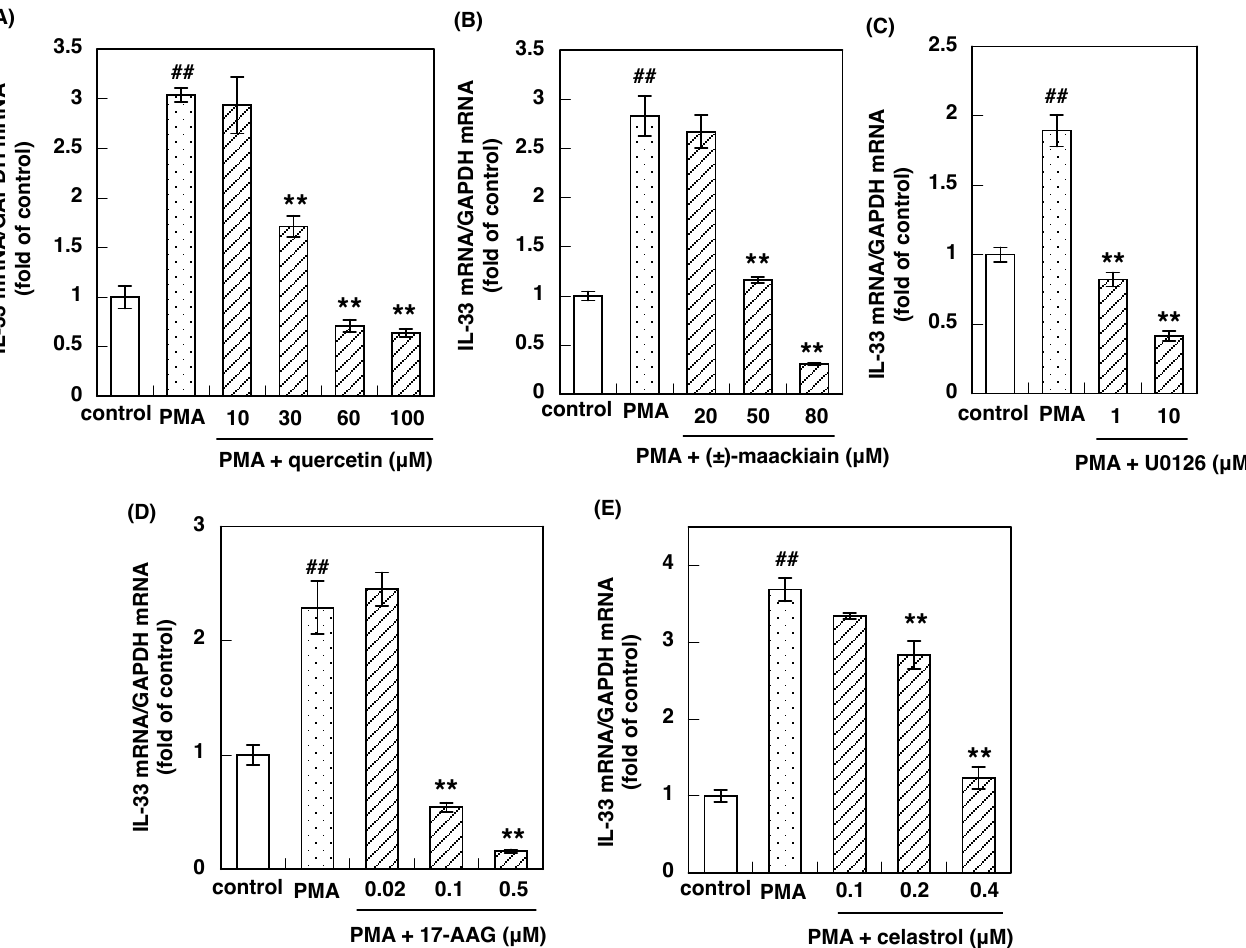
Figure 5. Effects of inhibitors of the H1R gene expression signaling pathway on PMA-induced IL-33 gene up-regulation. Swiss 3T3 cells were treated with quercetin ( A ), ( ± )-maackiain ( B ), U0126 ( C ), 17-AAG ( D ), and celastrol ( E ) for 12 h before stimulation with 100 nM PMA. After stimulation with PMA for 3 h, the cells were harvested, and total RNA was extracted. IL-33 mRNA levels were determined using quantitative RT-PCR. Data are expressed as means ± SEM ( n = 3–4). ## p < 0.01 vs. control; ** p < 0.01 vs.